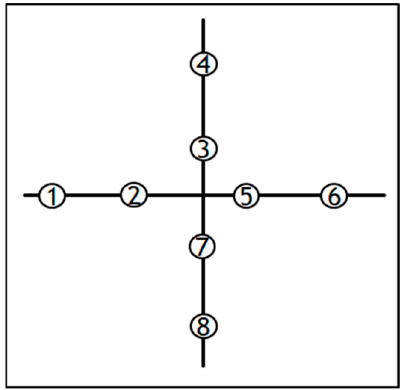
Figure 3. Conducting a shrinkage test using the cross method.